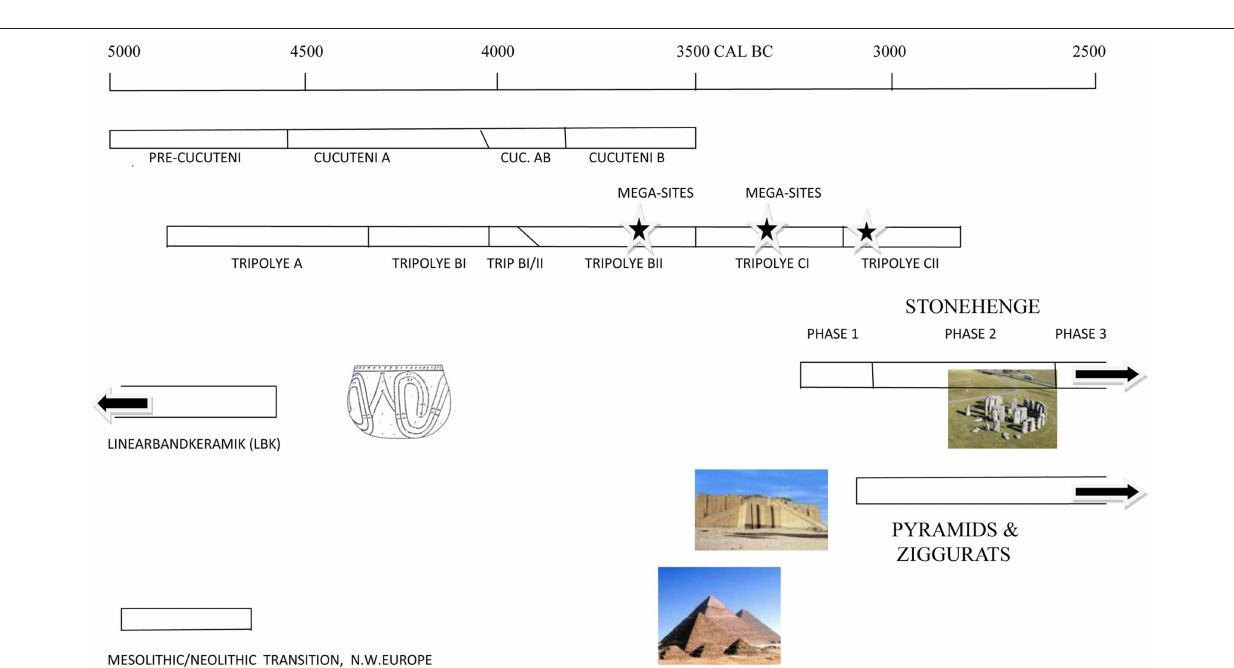
FIGURE 2 | Timeline for the Cucuteni—Trypillia group, showing (from the top) Cucuteni phases; Trypillia phases; the end of the Linearbandkeramik; the Mesolithic/Neolithic transition in NW Europe; the first three phases of Stonehenge; the start of the tradition of pyramid-building in Egypt and ziggurat-building in Mesopotamia (the